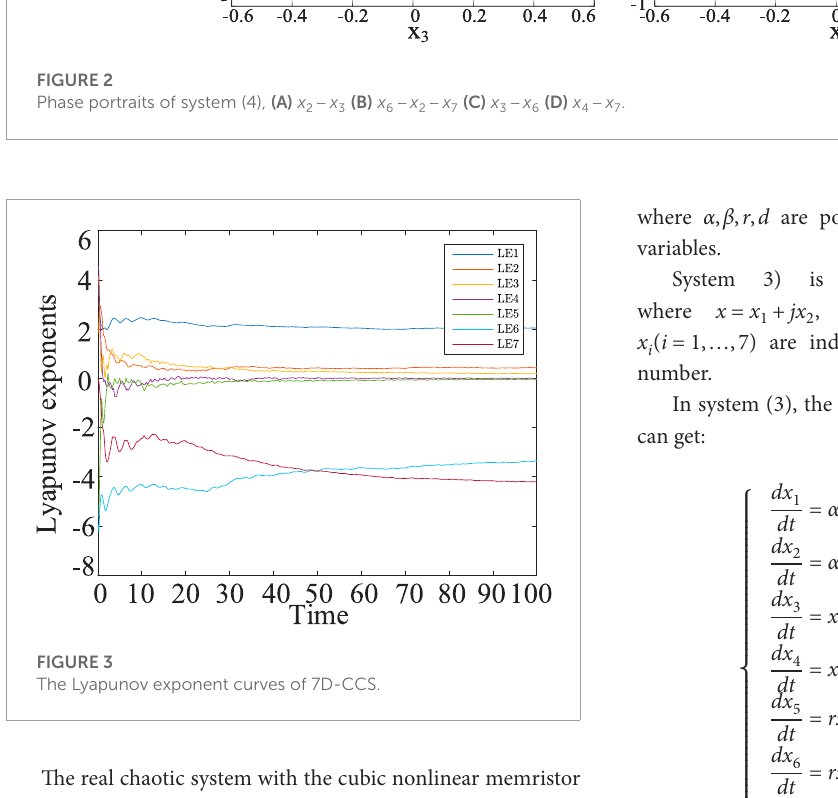
The real chaotic system with the cubic nonlinear